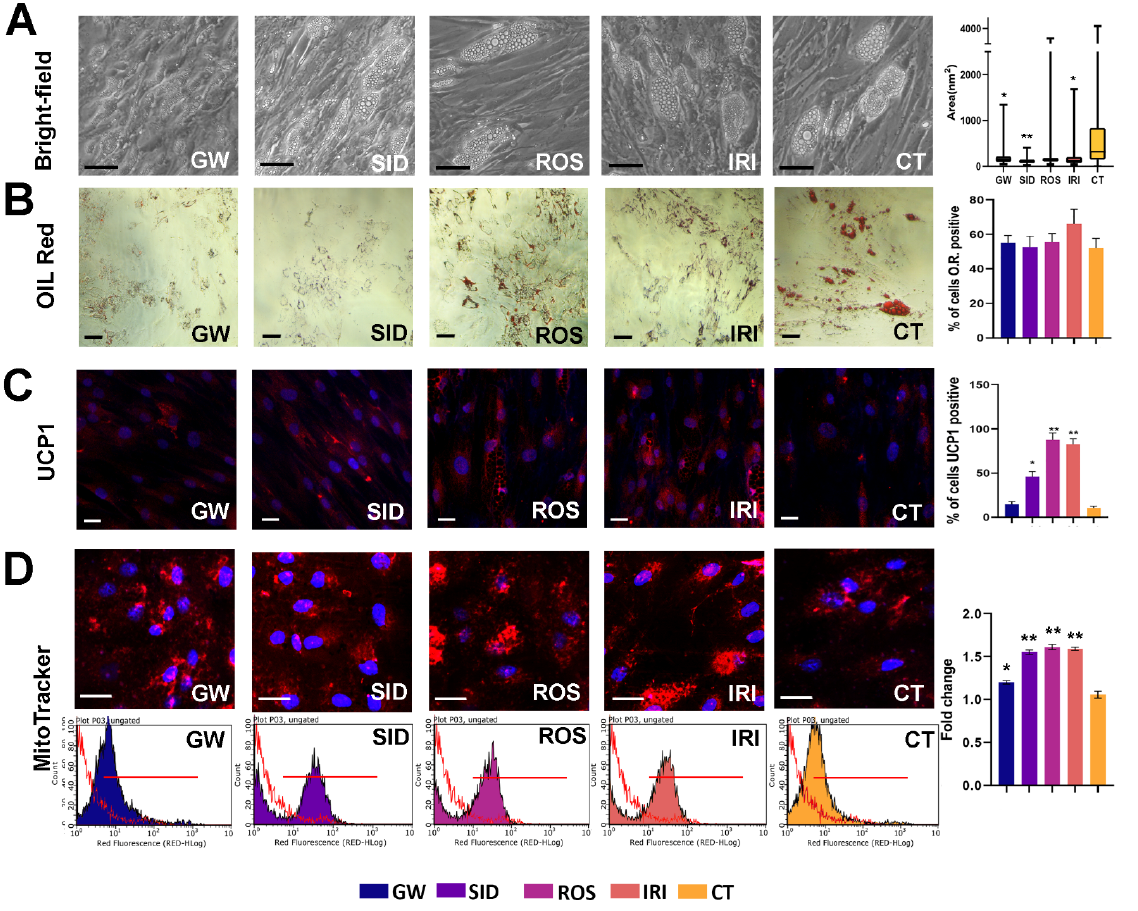
Figure 2. Lipid droplet size evaluation, Oil red O staining, UCP-1 expression, and MitoTracker analysis. ( A , B ): evaluation of lipid droplets by bright field analysis and Oil Red O staining in white adipocytes treated with browning agents for seven days. Scale bar: 50 µm. The right histogram of ( A ) shows the average droplet area in the different experimental conditions. For each cell, the size of lipid droplets was acquired with a CCD camera and analyzed with Quantity One 1-D analysis software (Bio-Rad Laboratories). We calculated the average droplet size, which was expressed in nm 2 . For every experimental condition, droplet size was determined by analyzing 100 cells. Data are expressed with standard deviation ( n = 3, * p < 0.05, ** p < 0.01). The right histogram of ( B ) shows the percentage of Oil Red O positive cells (±SD, n = 3 biological replicates). ( C ): evaluation of UCP- 1 expression detected in white adipocytes treated with browning agents for seven days. The UCP-1 level was detected in the cell cultures through antibodies against UCP-1 (Santa Cruz, TX, USA), according to the manufacturer’s instructions. The secondary antibody Alexa 594-conjugated was obtained from ImmunoReagents (Raleigh, NC, USA). Cell nuclei were stained with 4 ′ ,6-diamidino-2-phenylindole (DAPI) and then observed with a fluorescence microscope. The right histogram shows the percentage of UCP1-positive cells by counting a minimum of 500 cells in different microscope fields ( ± SD, n = 3 biological replicates; * p < 0.05, ** p < 0.01). ( D ): Analysis of mitochondrial mass in white adipocytes treated with browning agents for seven days. The micrograph showed the MitoTracker-stained mitochondria (red) in cells that were identified by DAPI nuclei staining (Blu). The graphs show the MitoTracker-stained cells acquired with Guava FACS Millipore Instruments; the red line corresponds to the unstained sample (negative control). The right histogram shows the intensity of MitoTracker staining as determined by FACS analysis. Data are reported as fold changes in intensity compared with control (white adipocytes) indicated as 1 ( ± SD, n = 3 biological replicates; * p < 0.05, ** p < 0.01). GW: GW501516; SID: sildenafil; ROS: rosiglitazone; IRI: irisin; CT: differentiated white adipocytes without analyzed drugs. Drug concentration: 1 nM (GW); 1 nM (SID); 43 nM (ROS); 20 nM